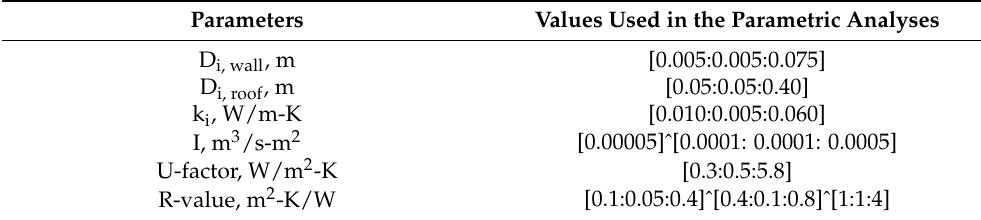
Table 2. Parametric analyses for optimization of the building envelope.